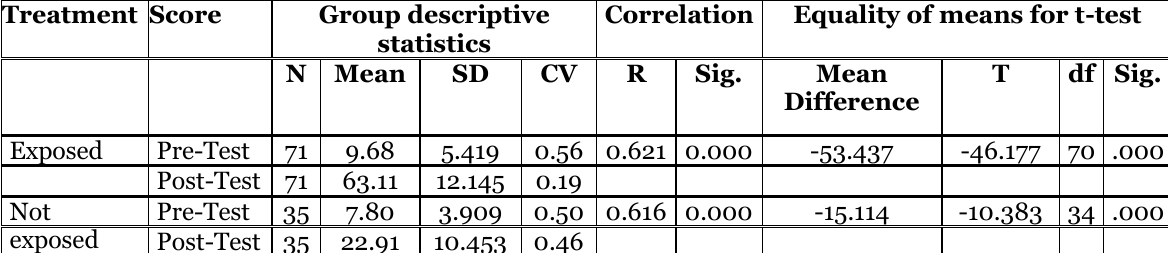
Descriptive Statistics and t-test for Equality of Means Treatment Score Group descriptive statistics